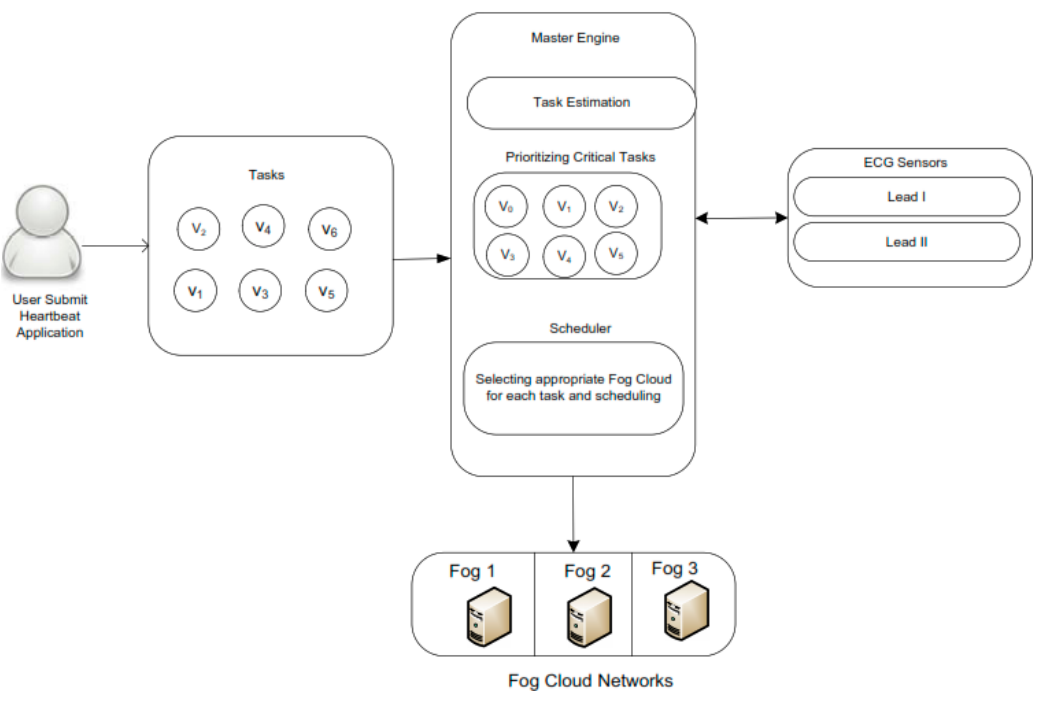
Figure 1. Healthcare Based Fog System.